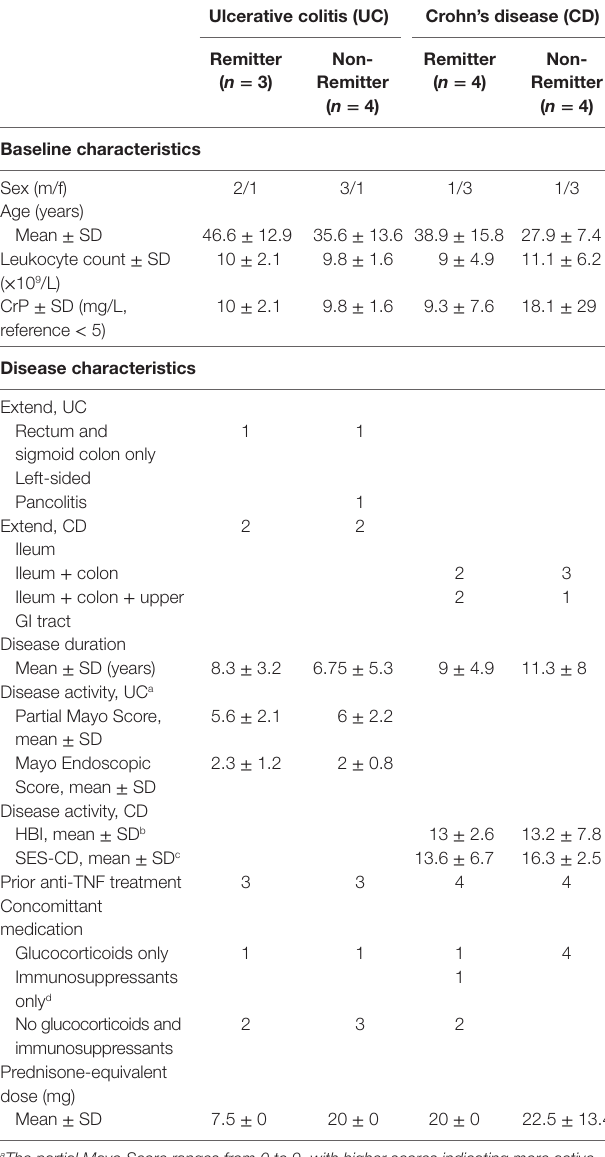
TaBle 3 | Clinical data of inflammatory bowel disease patients with α 4 β 7 quantification prior to anti-integrin therapy with